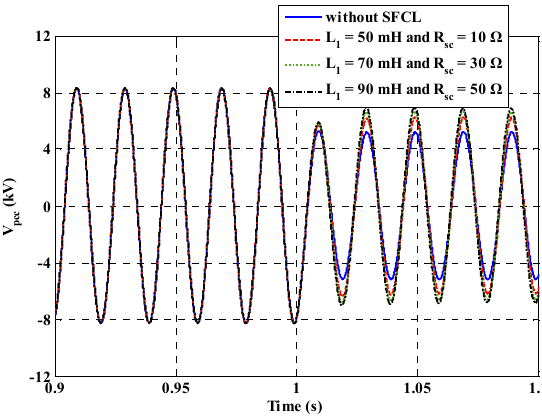
Figure 10. PCC voltage characteristic of the micro ‐ grid system under the external fault (A ‐ phase).